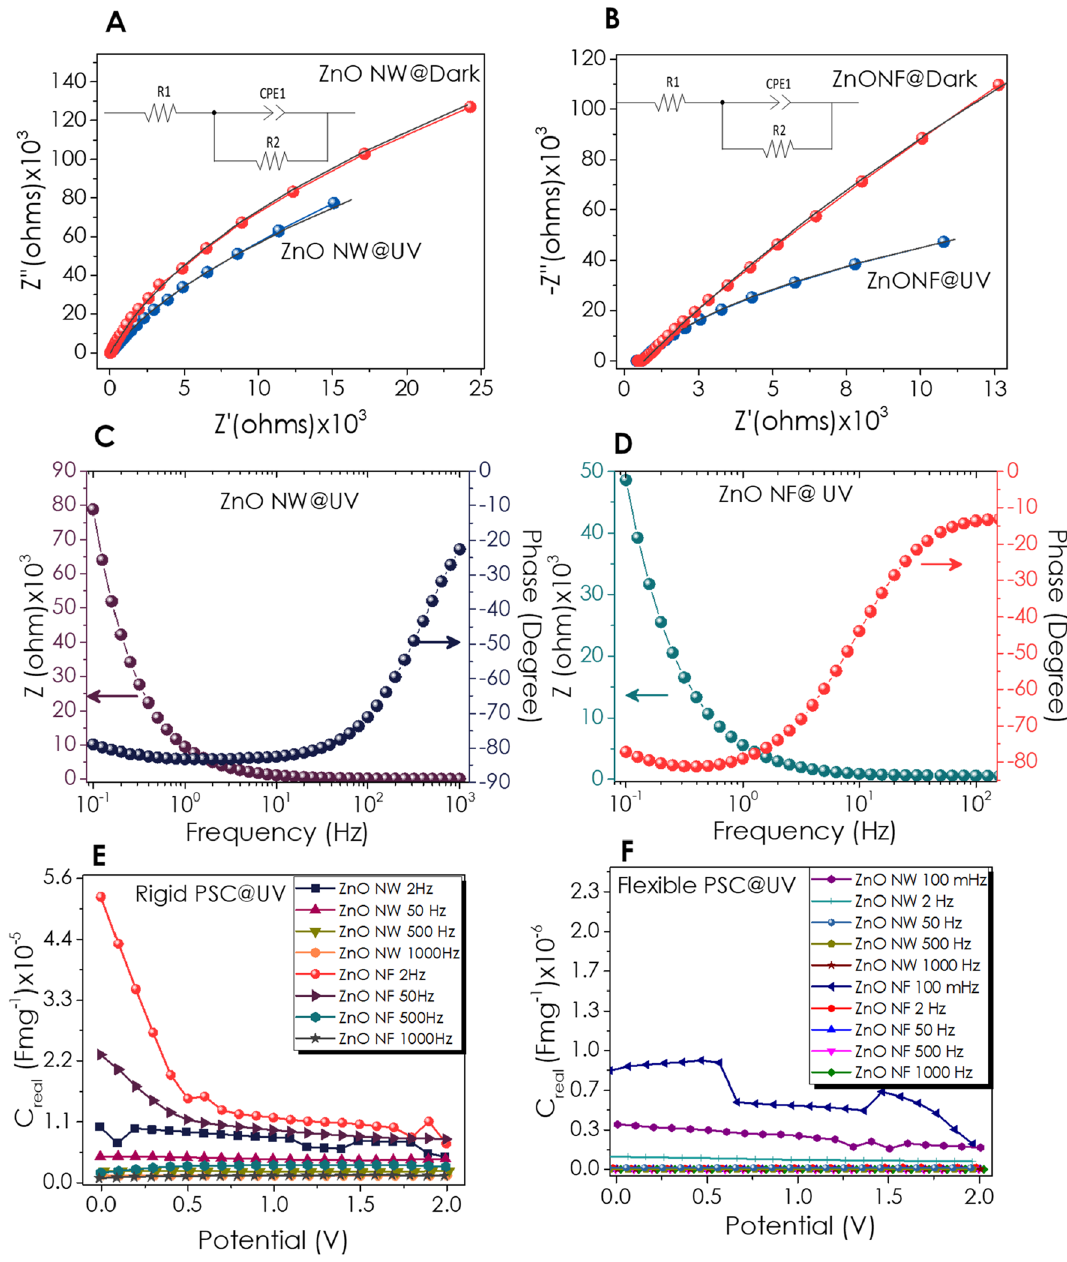
Figure 8. EIS measurements were performed in the scan range: 1 MHz to 0.1 Hz at 0 V. Nyquist Plot; ( A ) ZnO NW, ( B ) ZnO NF (The symbols stand for experimental data; the solid lines are the curves fitted to the electrical circuit model depicted in the inset), Bode plots ( C ) ZnO NW and (D) ZnO NF, Areal Capacitance at various frequencies at UV light (E) ZnO NW, (F) ZnO NF.